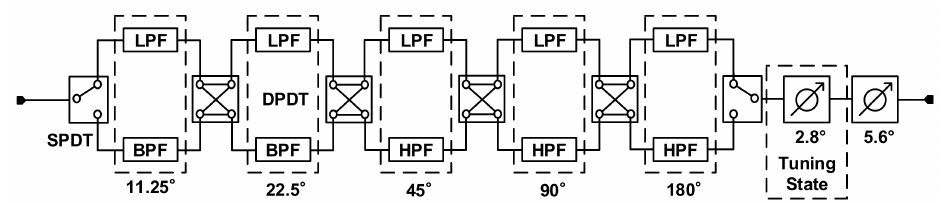
Figure 2. Block diagram of the Ku-band 6-bit phase